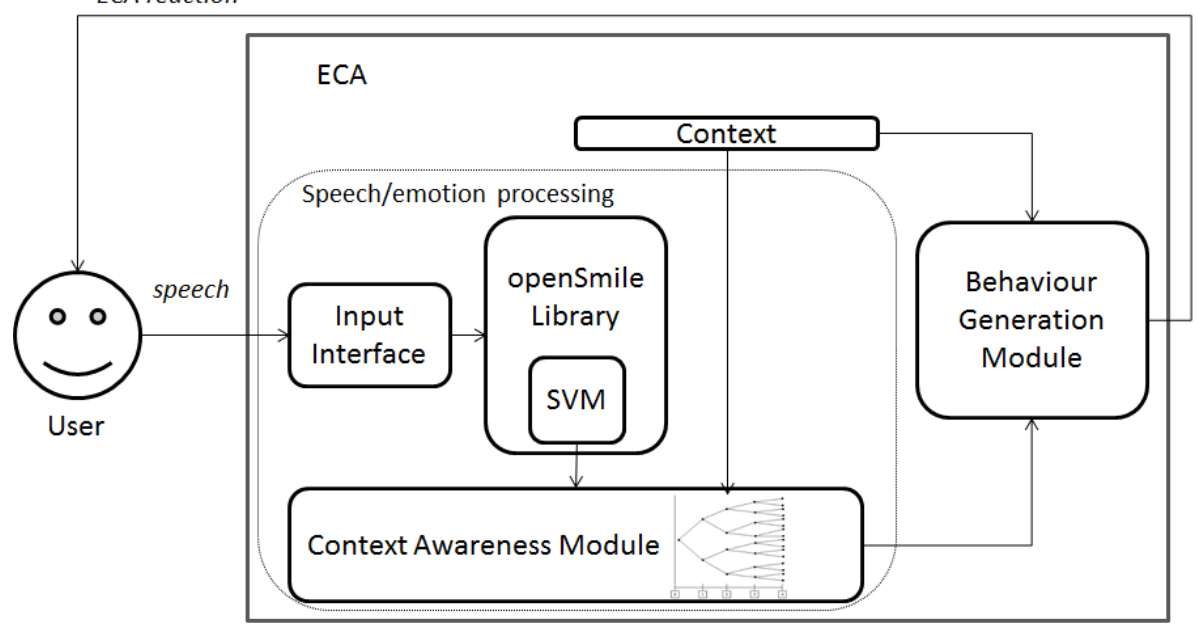
Figure 1. Flow diagram of the proposed